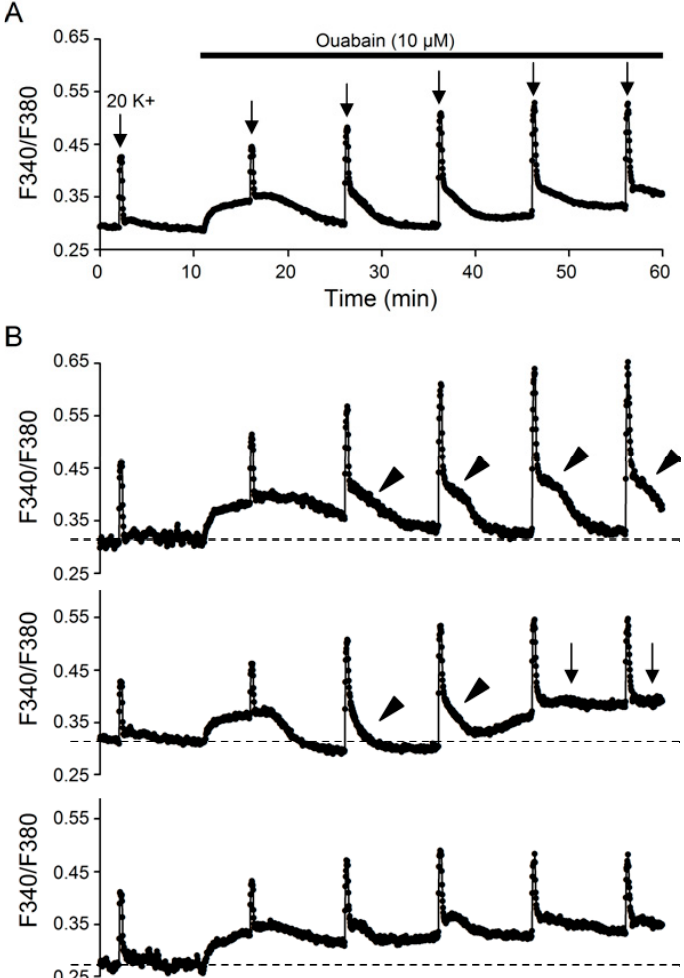
Figure 4. The 20 K + -evoked Ca 2 + transient has plateau-like slow decay phase in ouabain. ( A ) A representative experiment to demonstrate the appearance of plateau-like slow decay phase for the 20 K + -evoked Ca 2 + transient (an average of 18 cells) in the presence of ouabain. ( B ) Three representative cells to indicate the association of plateau-like slow decay phase (marked by arrowheads) with the level of basal [Ca 2 + ] i . Note that the plateau-like slow decay phase only appears when the basal [Ca 2 + ] i initially raised by ouabain has began to decrease back to or even below the resting level (top, middle). For the cell in middle panel, the plateau-like slow decay phase appears and then disappears (marked by arrows) when the basal [Ca 2+ ] i increases again to approach the initial high level.